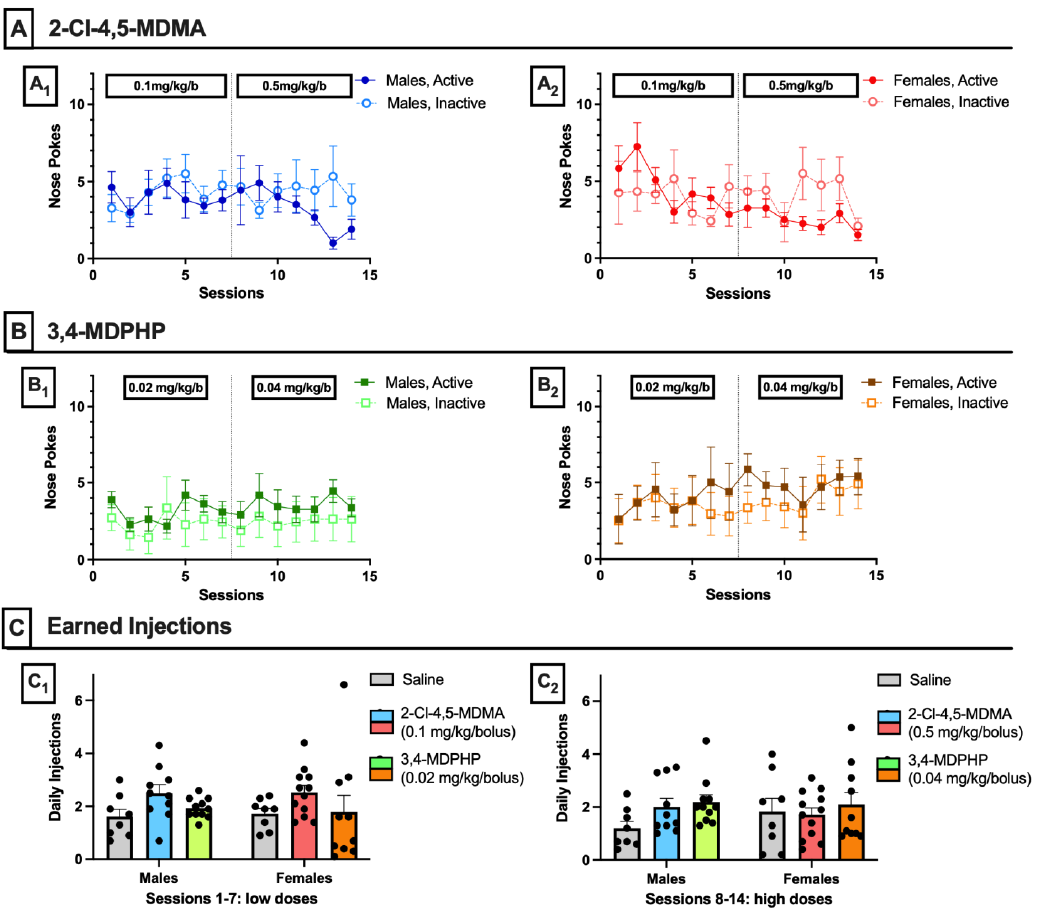
Figure 2. 2-Cl-4,5-MDMA and 3,4-MDPHP intravenous self-administration . ( A ) Cumulative nose- pokes (active and inactive) performed during intravenous self-administration sessions of 2-Cl-4,5- MDMA (0.1 and 0.5 mg/kg) by male ( A 1 ) and female ( A 2 ) rats. Data are expressed as mean ± SEM of nose-pokes recorded for each group (males: n = 10, females: n = 12). ( B ) Cumulative nose-pokes (active and inactive) performed during intravenous self-administration sessions of 3,4-MDPHP (0.02 and 0.04 mg/kg) by male ( B 1 ) and female ( B 2 ) rats. Data are expressed as mean ± SEM of nose-pokes recorded for each group (males: n = 11, females; n = 10). ( C ) Average daily injections of saline, 2-Cl-4,5-MDMA, or 3,4-MDPHP earned by male and female rats during self-administration of saline and low ( C 1 , sessions 1–7) and high doses ( C 2 , sessions 8–14) of 2-Cl-4,5-MDMA and 3,4-MDPHP (saline: males and females n = 8; 2-Cl-4,5-MDMA: males n = 10 and females n = 12; 3,4-MDPHP: males n = 11 and females n =